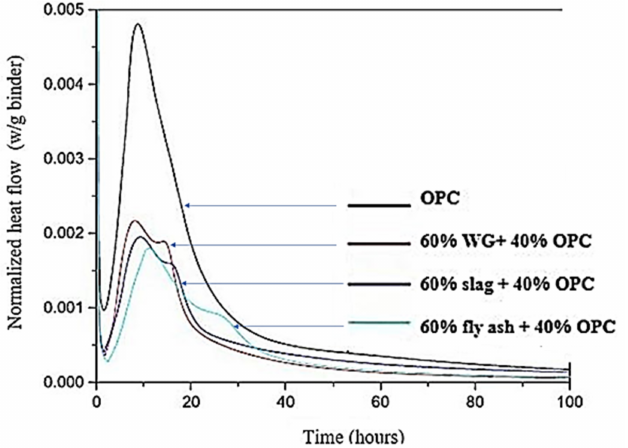
Figure 6. Heat flow during hydration of different binders